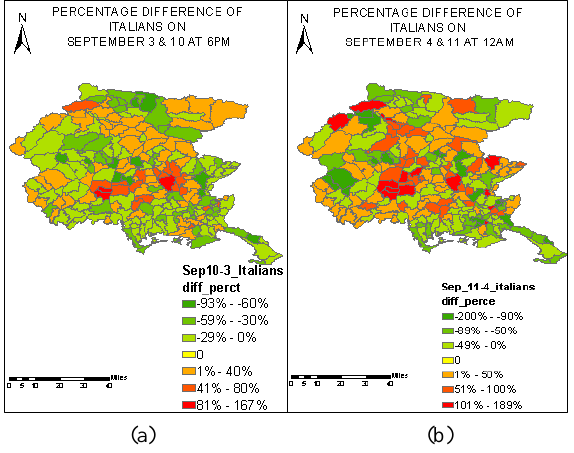
Figure 3.2.1-1(a) Presence of Italians on Sep 3 - 10 @ 6pm (b) Presence of Italians on Sep 4 - 11 @ 12